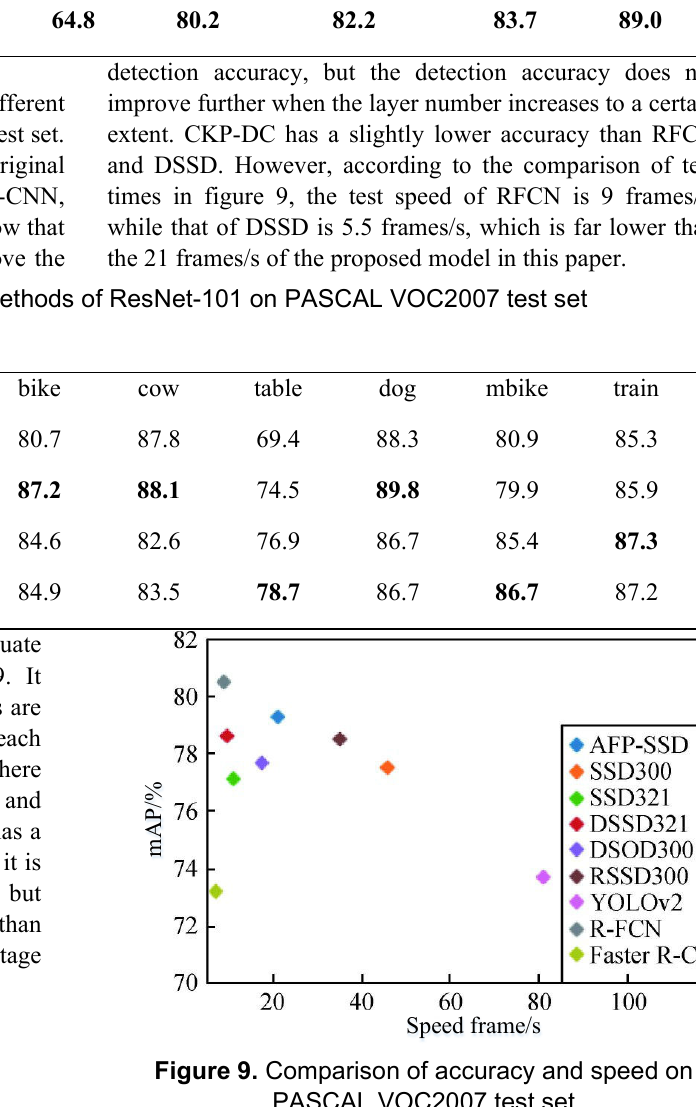
The UCAS-AOD remote sensing dataset contains 1000 images with aircraft, which are randomly divided into training sets and test sets in a 7:3 ratio. Each of the 1000 remote sensing images has a resolution of 1 280×659